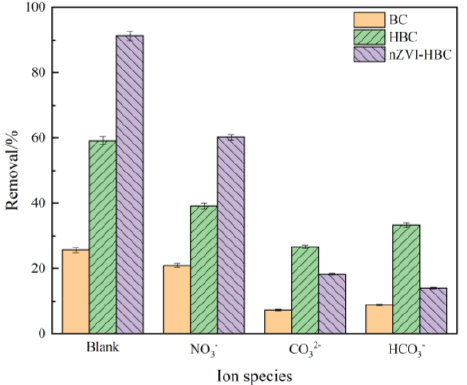
Figure 8. The effect of anions on OTC removal rate.